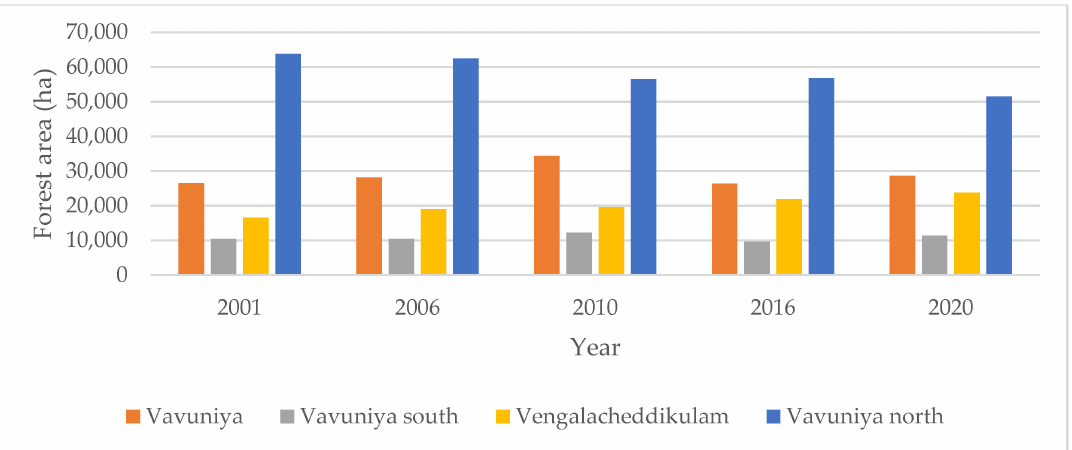
Figure 6. Forest cover change in DS divisions,